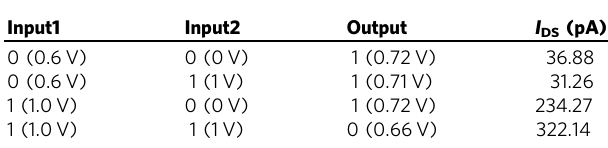
Table 1 Measurement data of the one-transistor design for logic NAND ( V DS = 0.72 V).